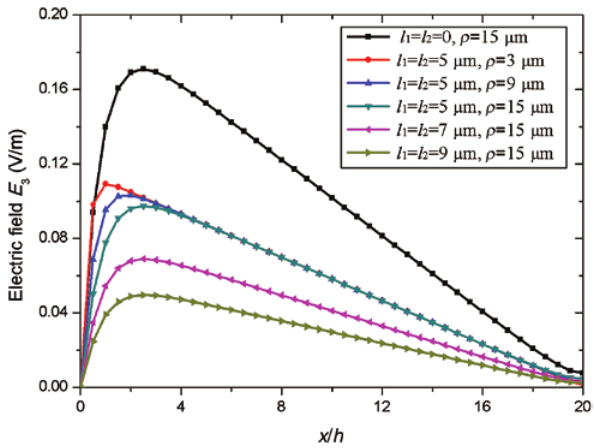
at z = h /2 along the beam 3